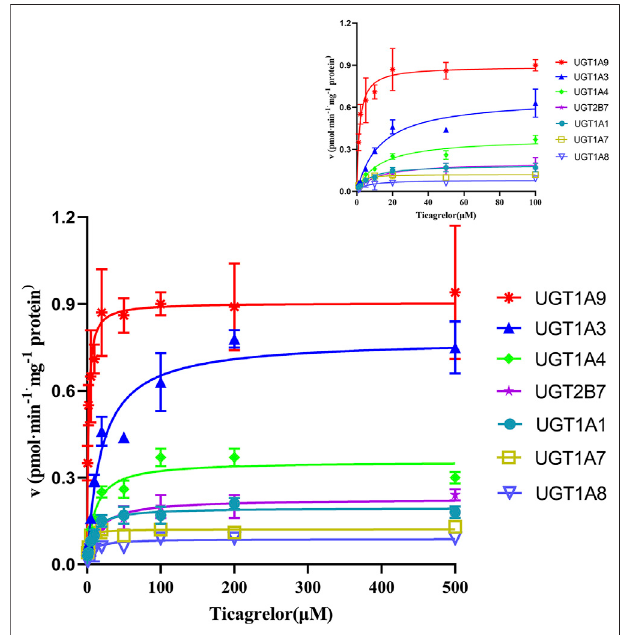
FIGURE 4 | Enzyme kinetics of ticagrelor glucuronidation by human recombinant UGT1A9, UGT1A3, UGT1A4, UGT2B7, UGT1A1, UGT1A7 and UGT1A8. Each point represents the mean ± S.D. of triple